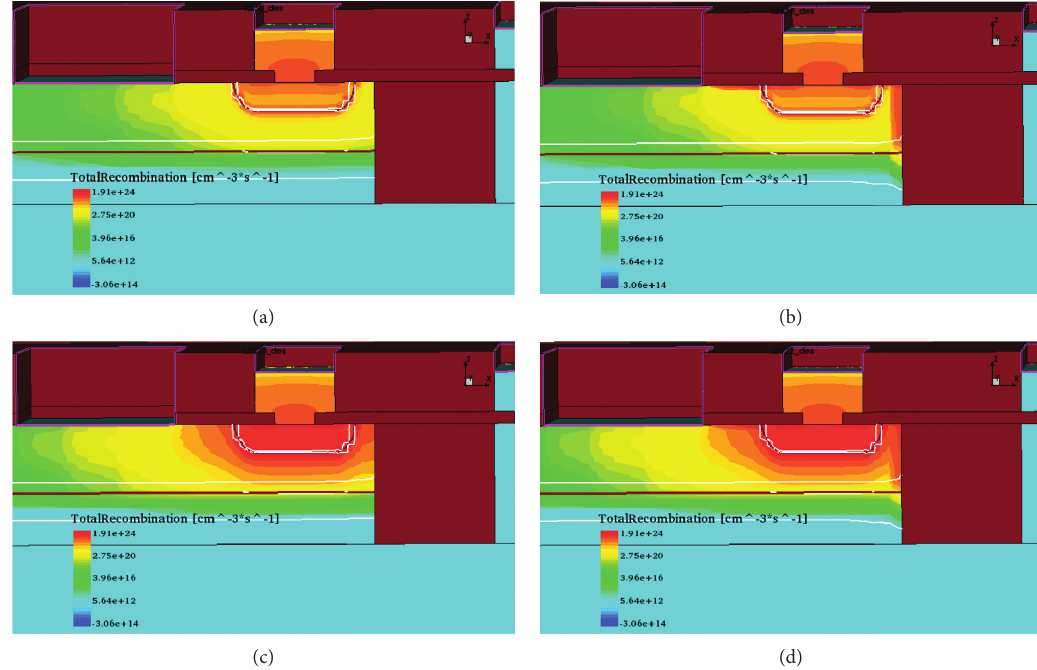
Figure 6: The recombination rate of carriers in the transistor. (a) Before radiation. (b) Irradiated with 100krad (SiO with 4 × 10 13 cm − 2 neutrons. (d) Irradiated with both 100krad (SiO 2 ) gamma rays and 4 × 10 13 cm − 2 neutrons simultaneously.